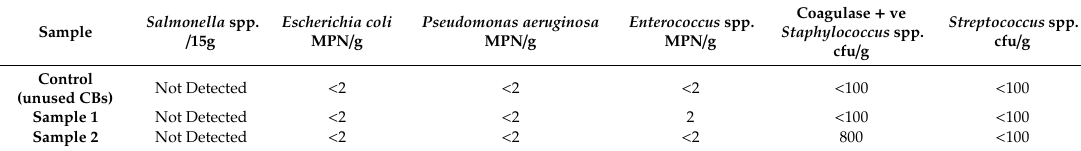
Table 3. Preliminary bacteriological test results for used and unused CBs (Pilot investigation